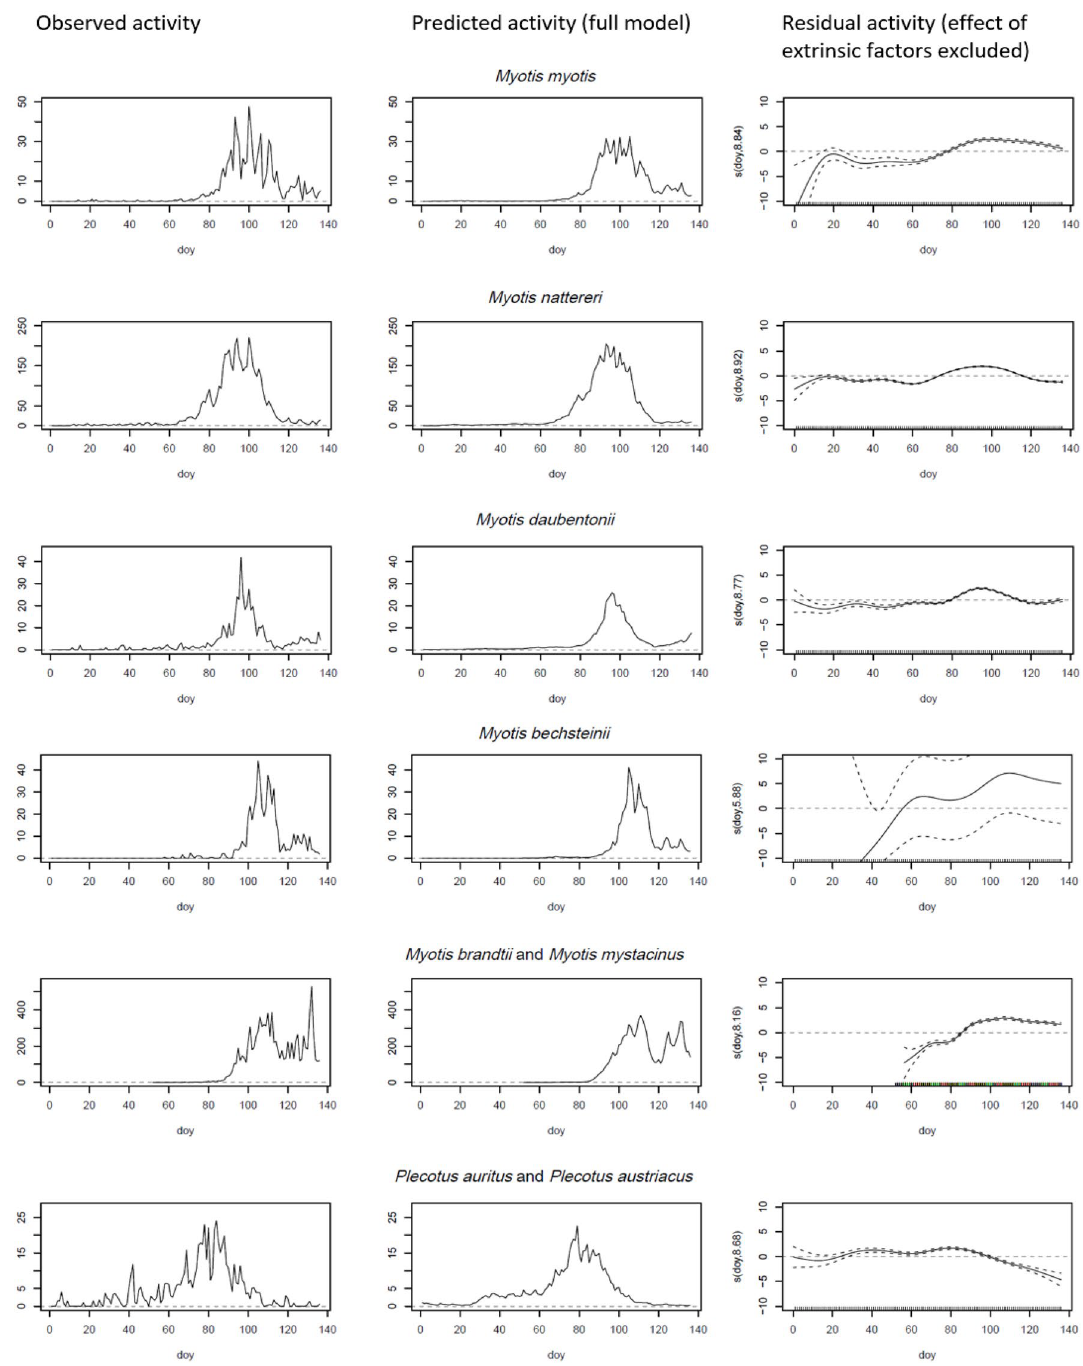
Figure 1. Observed (left column) and predicted spring activity (day 0–136) of bats at five hibernacula, predicted either by the full model (middle column) or by residual triggers alone (right column); horizontal dotted line at value 0 for